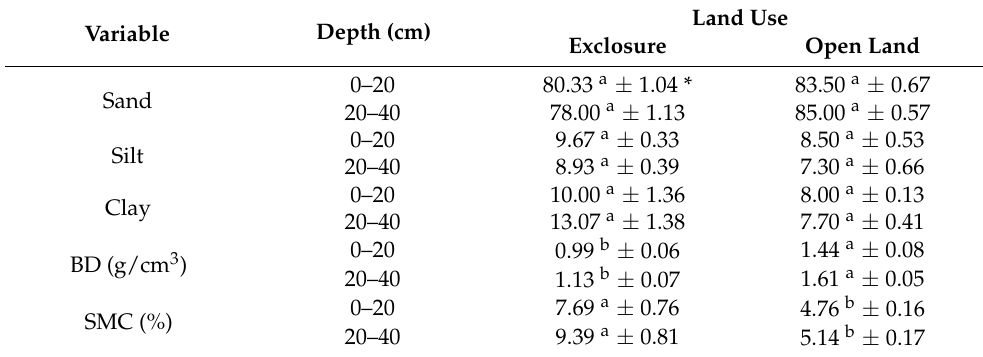
Table 1. Soil physical properties of the exclosure and open land.